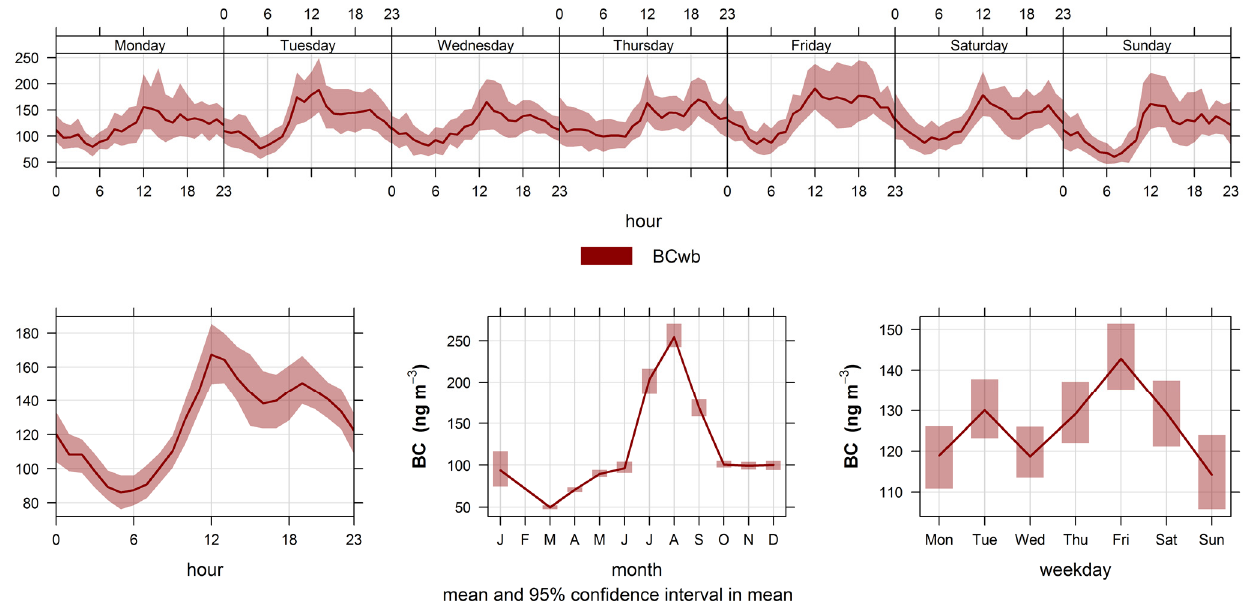
Figure A2. Time plot of hourly BC ff and BC wb concentrations, 2020 campaign.